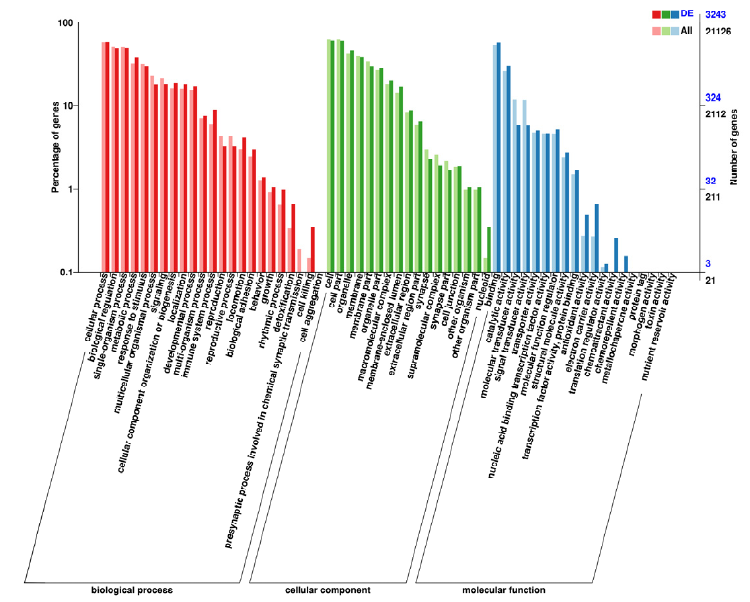
Figure 5. Analysis of DEGs and pathways derived from mouse spleens infected with P. multocida . ( A ) Heatmap of DEGs. Colors from blue (low) to red (high) represent DEG expression level. Each row in the map represents a sample, and each column represents a gene. ( B ) Kyoto Encyclopedia of Genes and Genomes (KEGG) pathway analysis of up- and down-regulated DEGs. Dot size repre- sents the number of genes. The rich factor indicates the ratio between the number of genes annotated for a KEGG pathway and the number of all genes annotated for the KEGG pathways.